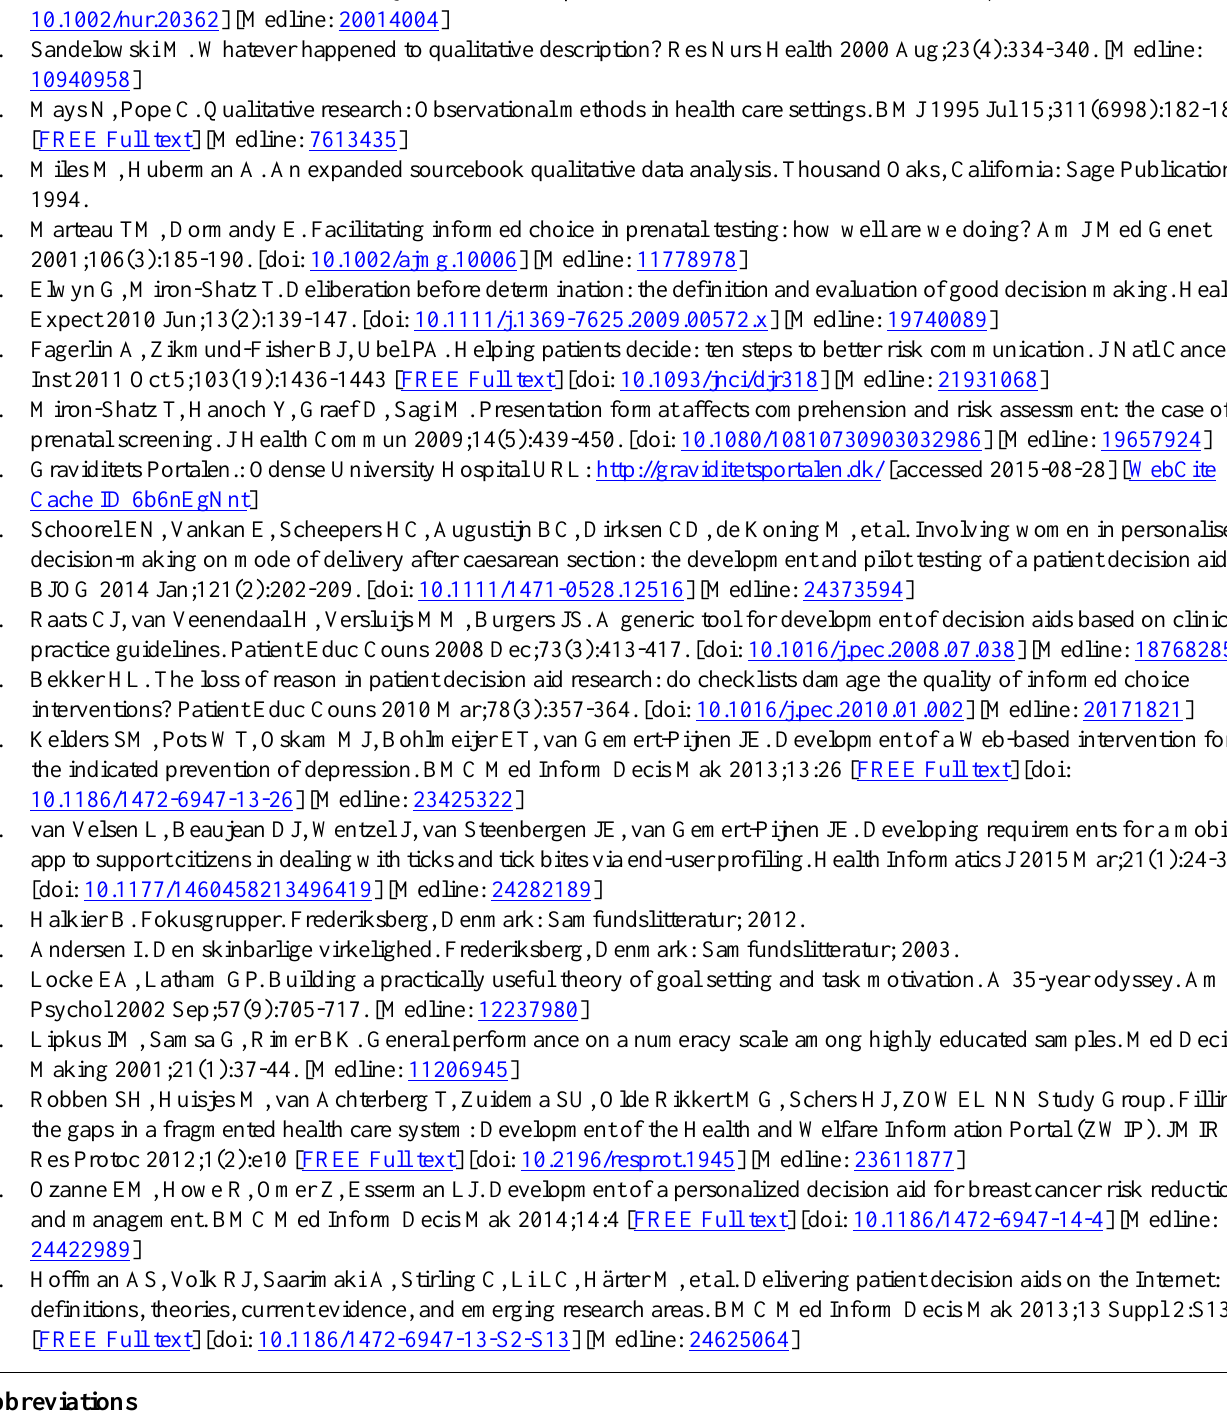
CeHRes: Center for eHealth Research and Disease Management IPDAS: International Patient Decision Aid